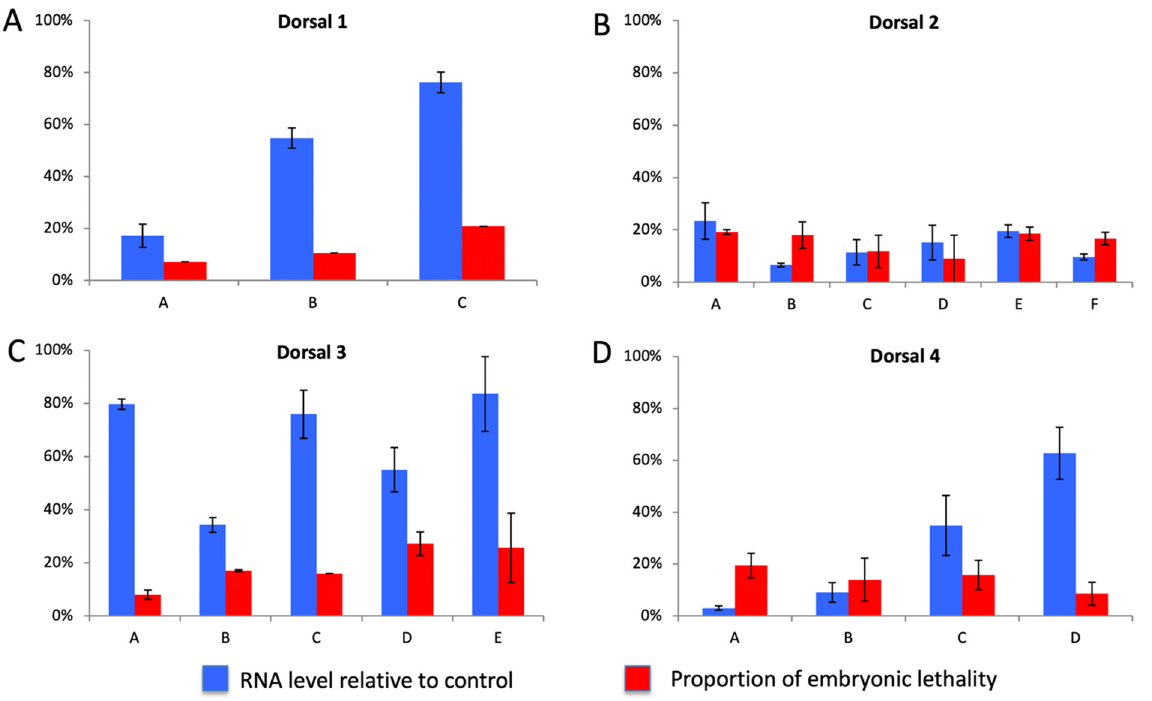
Figure 10. mRNA expression and embryonic lethality following pRNAi. ( A – D ) Relative transcript expression (blue) following pRNAi as a percentage of wildtype expression compared to the percentage of eggs laid that failed to develop into larva (embryonic lethality, red) from the same batch of wasps following pRNAi treatment. The X -axis represents different batches of RNAi injected wasps. Wasps were injected with dsRNA targeting dorsal1 ( A ), dorsal2 ( B ), dorsal3 ( C ), dorsal4 ( D ). Error bars represent standard